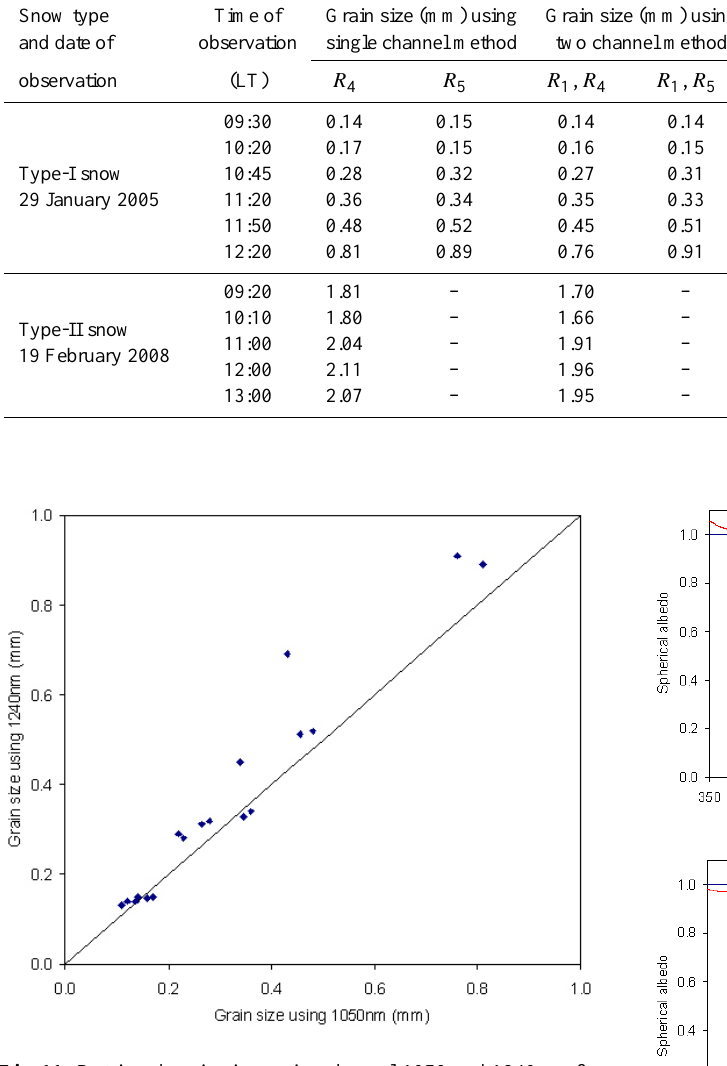
Fig. 11. Retrieved grain sizes using channel 1050 and 1240nm for snow Type-I.